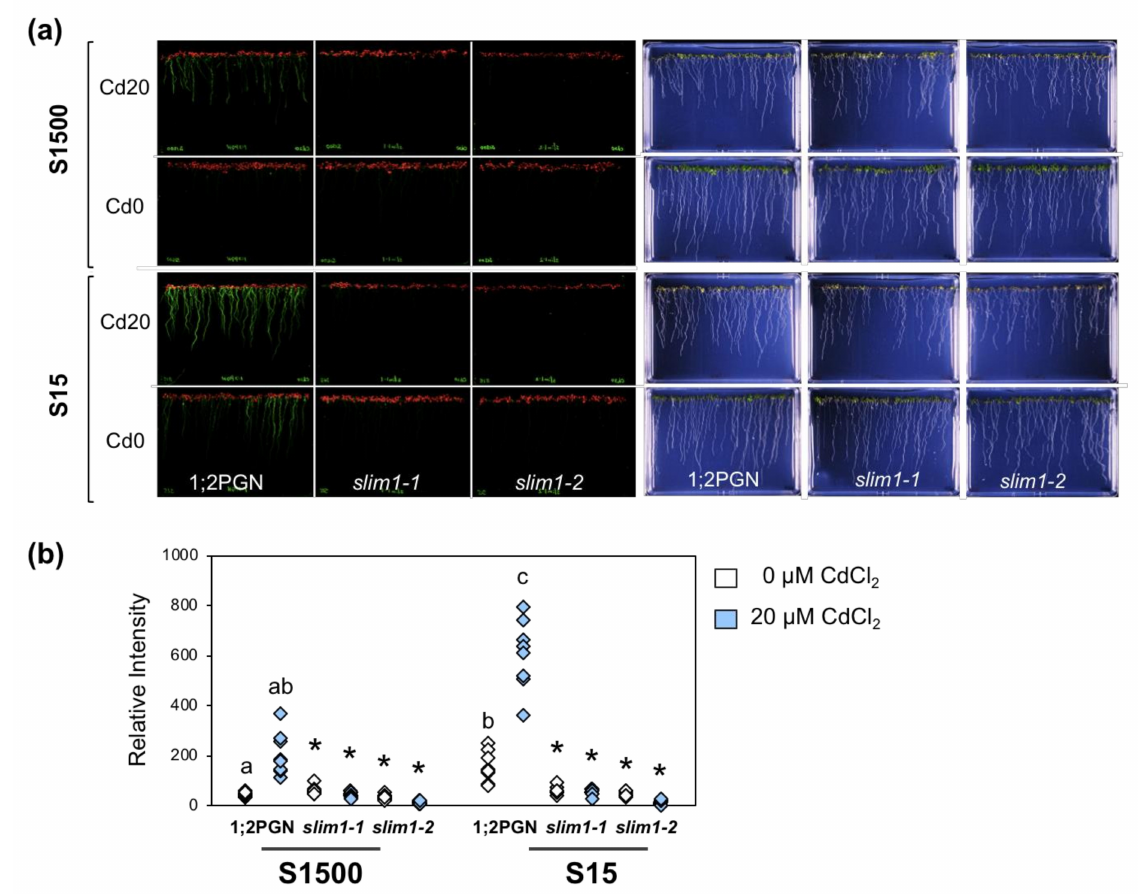
Figure 5. E ff ects of Cd treatment and − S on GFP and SULTR1;2 levels in 1;2PGN and slim1-2 plants. 1;2PGN, slim1-1 and slim1-2 seedlings were grown for 10 days on MGRL agar medium supplemented with 1500 or 15 µ M sulfate (S1500 or S15, respectively), which contained 0 or 20 µ M CdCl 2 . ( a ) GFP fluorescence in P SULTR1;2 -GFP plants was visualized using an image analyzer. Fluorescent images (left panels) and bright field images (right panels) are presented. ( b ) Relative GFP fluorescent intensities in (a) were processed by ImageQuant TL. The fluorescence intensities of plant roots grown on the agar medium containing 0 (white diamonds) or 20 (light blue diamonds) µ M CdCl 2 are displayed ( n = 6). Di ff erent letters indicate significant di ff erences between treatments in 1;2PGN (Tukey–Kramer test; p < 0.05). Asterisks indicate significant di ff erences between 1;2PGN and slim1 mutants (Student’s t -test; * p <